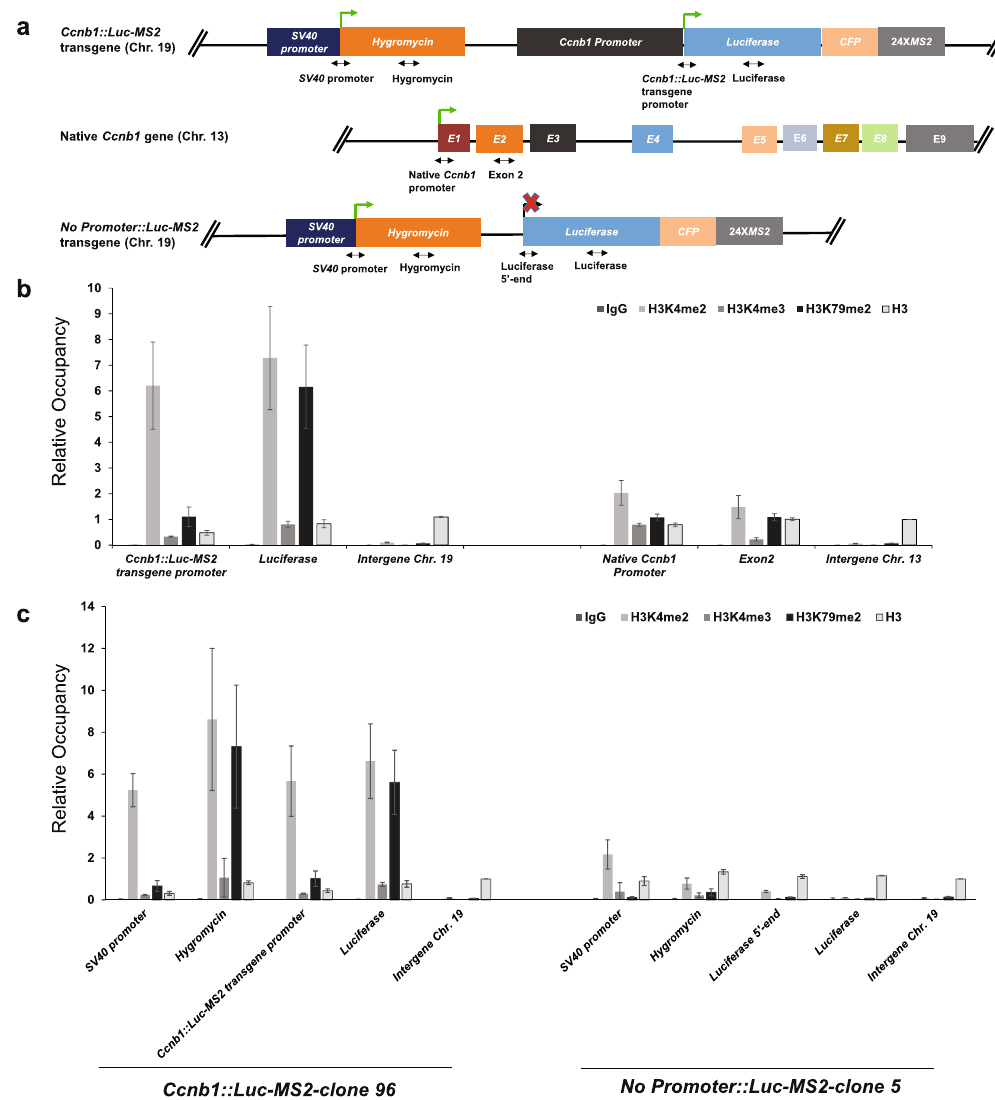
Figure 7. Differential enrichment of active histone modifications and nucleosome occupancy at the Ccnb1 :: Luc - MS2 transgene locus, the native Ccnb1 gene and the No Promoter :: Luc - MS2 transgene locus. ( a ) Schematic of the Ccnb1 :: Luc - MS2 transgene locus, the native Ccnb1 gene, the No Promoter :: Luc - MS2 transgene and the locations of ChIP-qPCR amplicons at each gene locus. Distances between Ccnb1 :: Luc - MS2 transgene promoter and Luciferase amplicons and between native Ccnb1 promoter and exon 2 amplicons are 686 bp and 1,238 bp, respectively. The Chr. 19 intergene amplicon is located at 7.5 kb upstream of the FRT insertion site. The Chr. 13 intergene amplicon is located at 10.4 kb upstream of 5 ′ -end of the native Ccnb1 gene. ( b ) ChIP analysis for H3K4me2, H3K4me3, H3K79me2 and histone H3 at the Ccnb1 :: Luc - MS2 transgene and the native Ccnb1 gene in Ccnb1 :: Luc - MS2 -clone 96 cells. ( c ) ChIP analysis for H3K4me2, H3K4me3, H3K79me2 and histone H3 at the Ccnb1 :: Luc - MS2 transgene from Ccnb1 :: Luc - MS2 -clone 96 cells, and at the No Promoter :: Luc - MS2 transgene from No Promoter :: Luc - MS2 -clone 5 cells, respectively. In panels b and c, relative occupancies were determined by the percent input of each ChIP DNA by antibodies against each histone mark normalized to percent input of histone H3 enrichment at the Ccnb1 intergenic region on chromosome 13. Error bars represent standard deviations of three independent experiments, each performed in